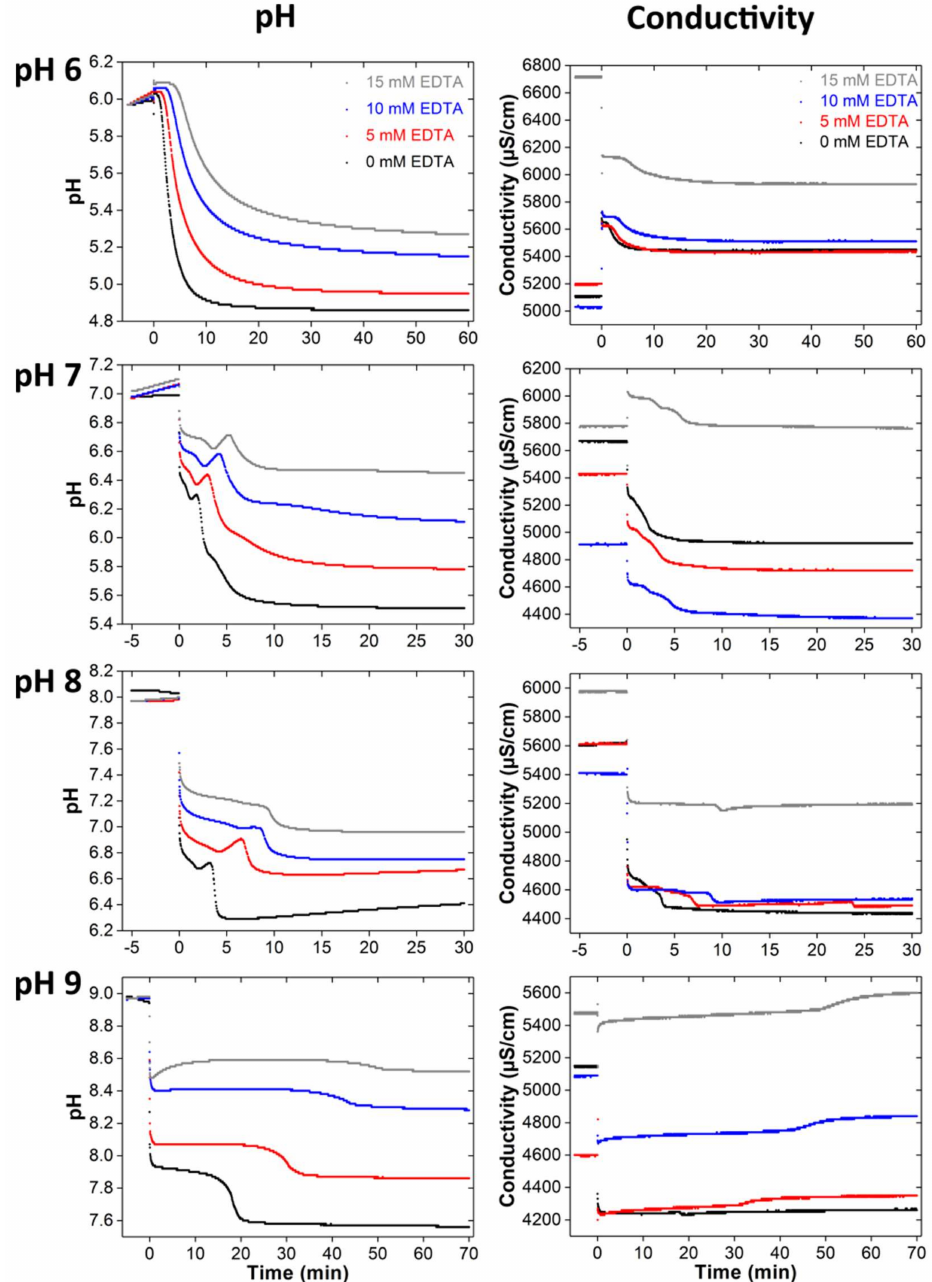
Figure 6. pH and conductivity curves of samples mineralized at different EDTA concentrations (0, 5, 10 and 15 mM) and starting pH (6–9). Note that the mineralization times are different. Long time measurements have shown that the values do not change anymore after the reaction times shown here; the corresponding data are therefore not